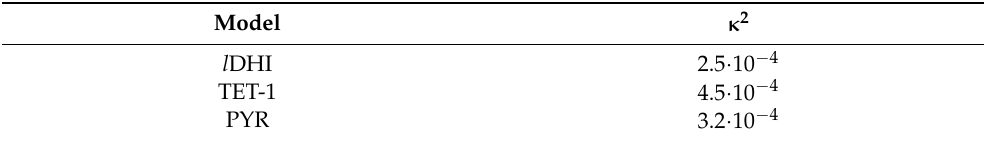
Figure 8. Representation of one configuration for the different PDA models (left to right: l DHI, TET-1, and PYR) in implicit solvent from the MD simulations.